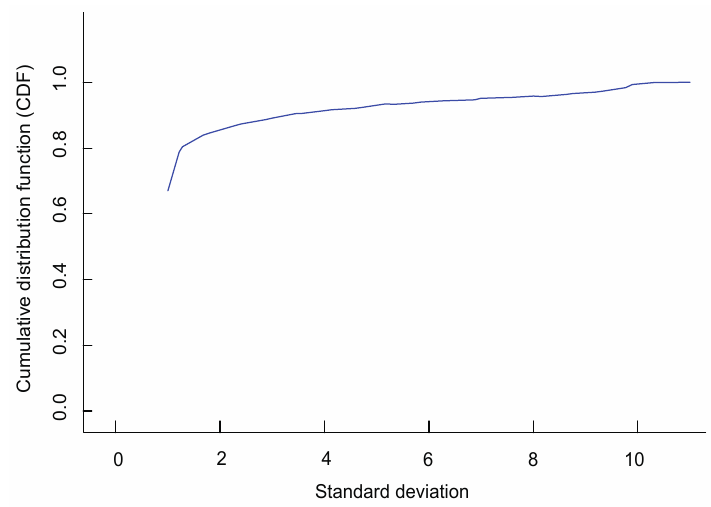
Figure 4. Cumulative Distribution Function (CDF) for depth estimates, given as a percentage of the total pixels in the reconstruction. The CDF gives the percentage of total pixels in the image with a variance less than or equal to a given value of σ . Here σ = 0.1 mm and 77% of the pixels in the reconstruction have a depth that is within 3 σ = 0.3 mm of the ground-truth depth.